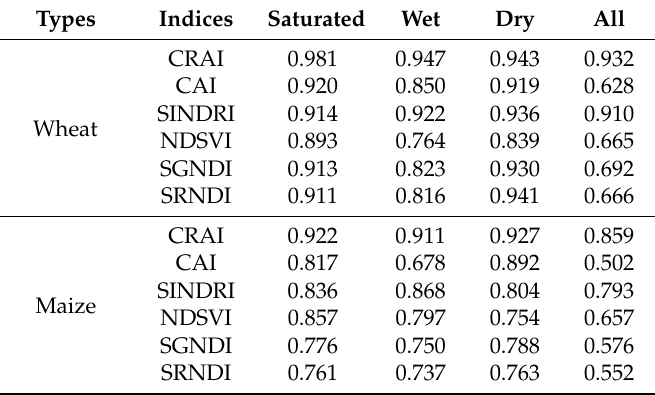
Table A2. Absolute value of correlation